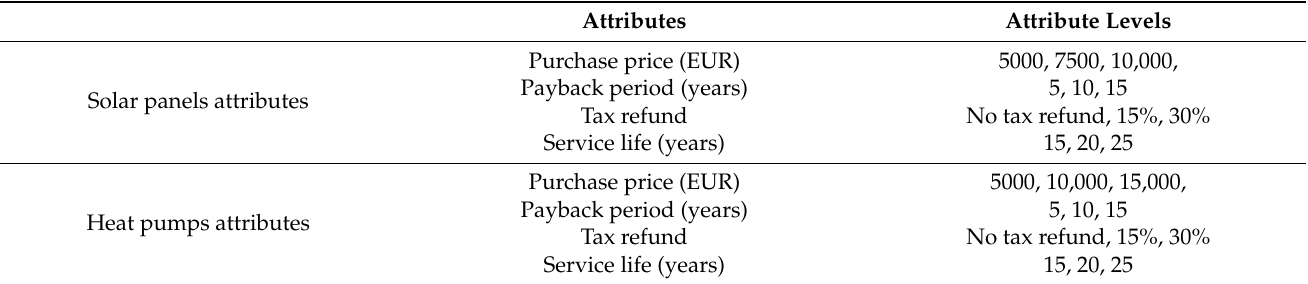
Table 2. Selected attributes and attribute levels of energy